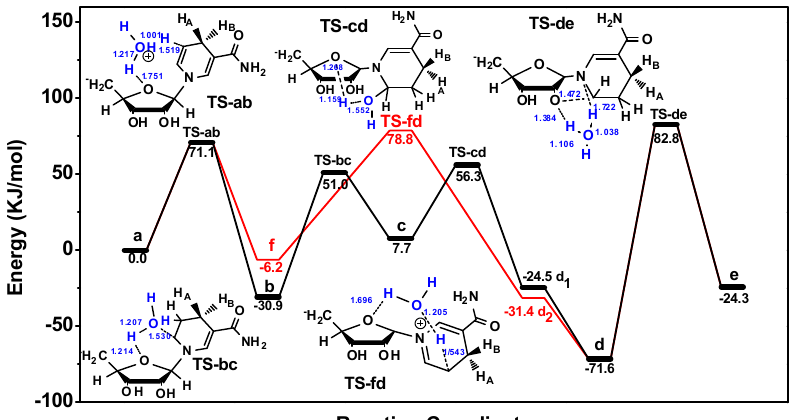
Figure 3. 1 H NMR (600 MHz, D 2 O, 298 K) (δ: ppm) study. ( A ) BmimBF 4 ; ( B ) NADH; ( C ), NAD + ; ( D ) a mixture of NADH and BmimBF 4 (molar ratio = 1:1); * signals for imidazolium C(sp 2 )-H.